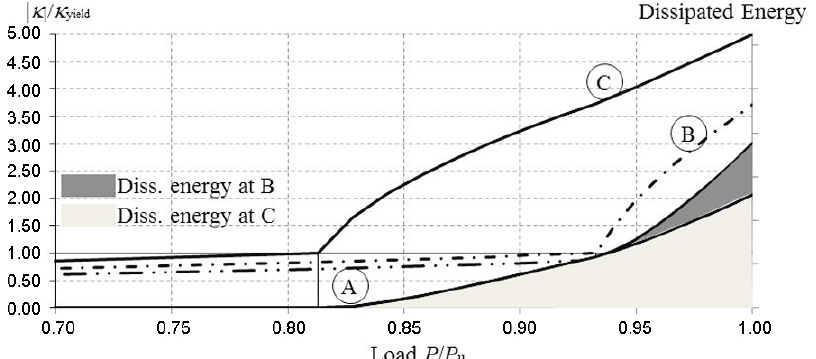
Fig. 7. Relative curvatures in points A, B and C and dissipated energy as function of the load